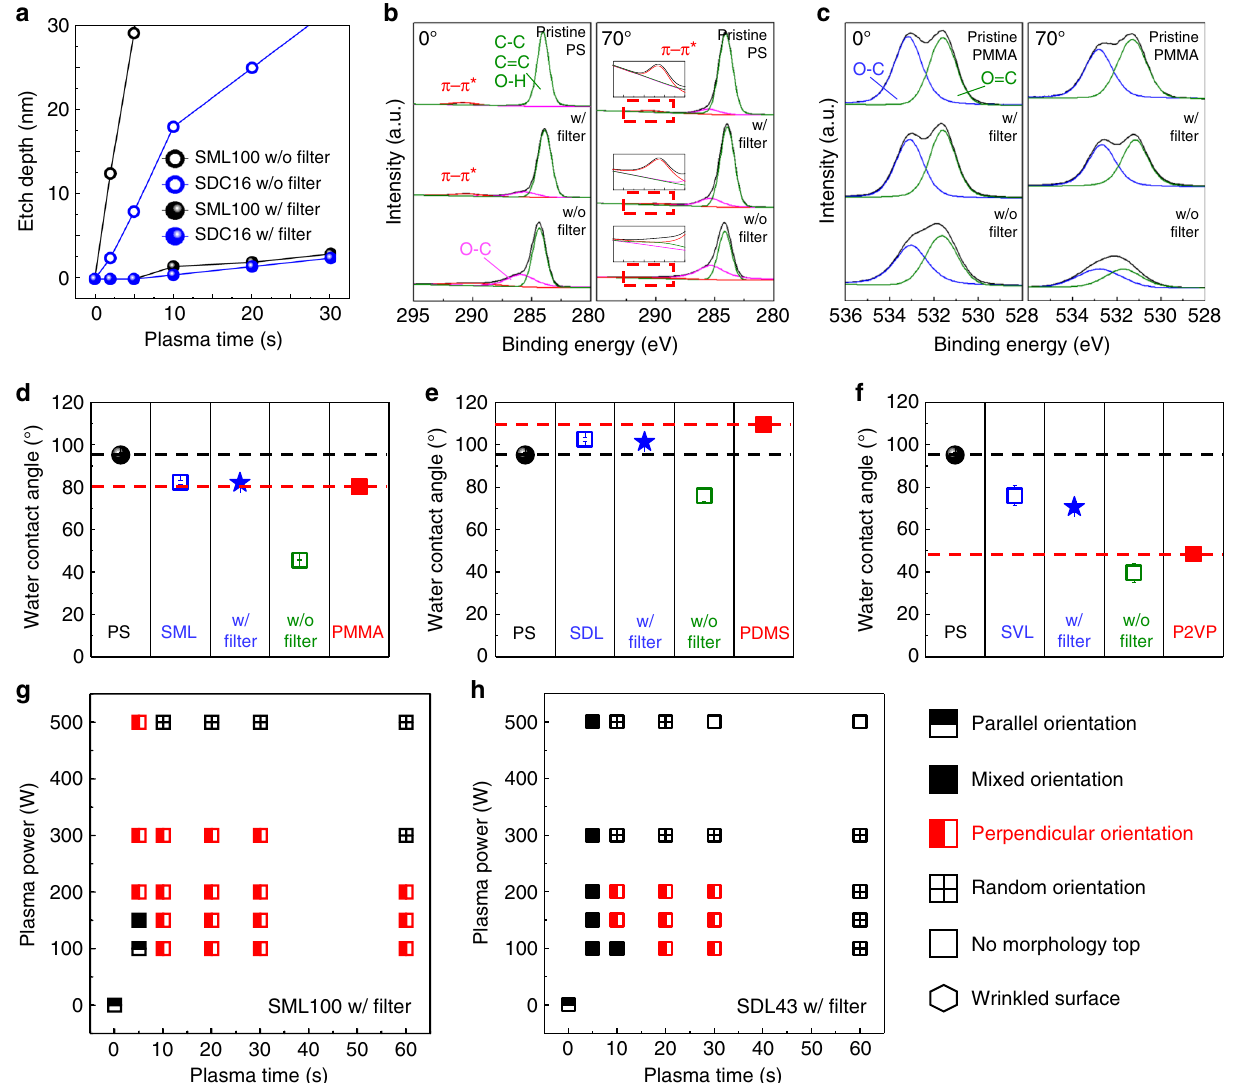
Fig. 4 Surface characteristics of plasma treated polymer fi lms with and without the fi lter. a Etch rate of PS- b -PMMA (SML100, black) and PS- b -PDMS (SDC16, blue) BCP fi lms with ( fi lled circle) and without (empty circle) the fi lter in a 200 W Ar plasma. b , c XPS spectra of PS ( b , C1 s ) and PMMA ( c , O1 s ) homopolymers: pristine fi lm, after fi ltered plasma treatment (200 W, 60 s) and after plasma without fi lter (200 W, 10 s) with incidence angles of 0° and 70°. d – f Water contact angles of homopolymer fi lms (black (PS) and red (PMMA, PDMS or P2VP, squares), as-cast BCPs (SML100, SDL43 or SVL84, blue hollow squares), fi ltered plasma treated BCPs (blue squares) and un fi ltered plasma treated BCPs (green squares). Error bar represent the standard error of measured water contact angle from at least fi ve independent experiments. g , h Orientational phase diagrams of ( g ) SML100 and ( h ) SDL43 treated with a fi ltered plasma for different powers and times. A red standing rectangle represents condition that yield perpendicular orientation of the microdomains, and a lying rectangle is a parallel orientation, a fi lled square is a mixed orientation, a crossed square is a partial perpendicular, an empty square is